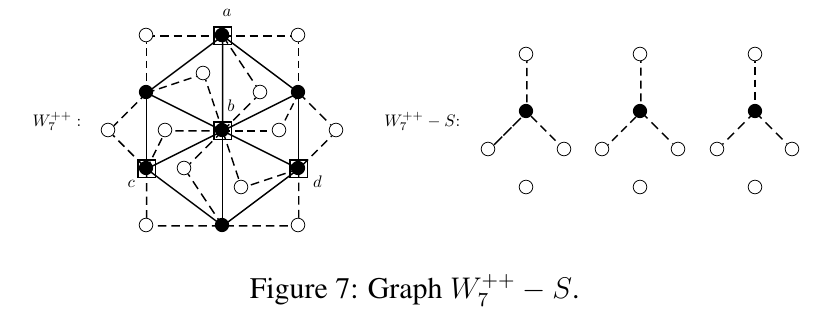
Figure 7: Graph W ++